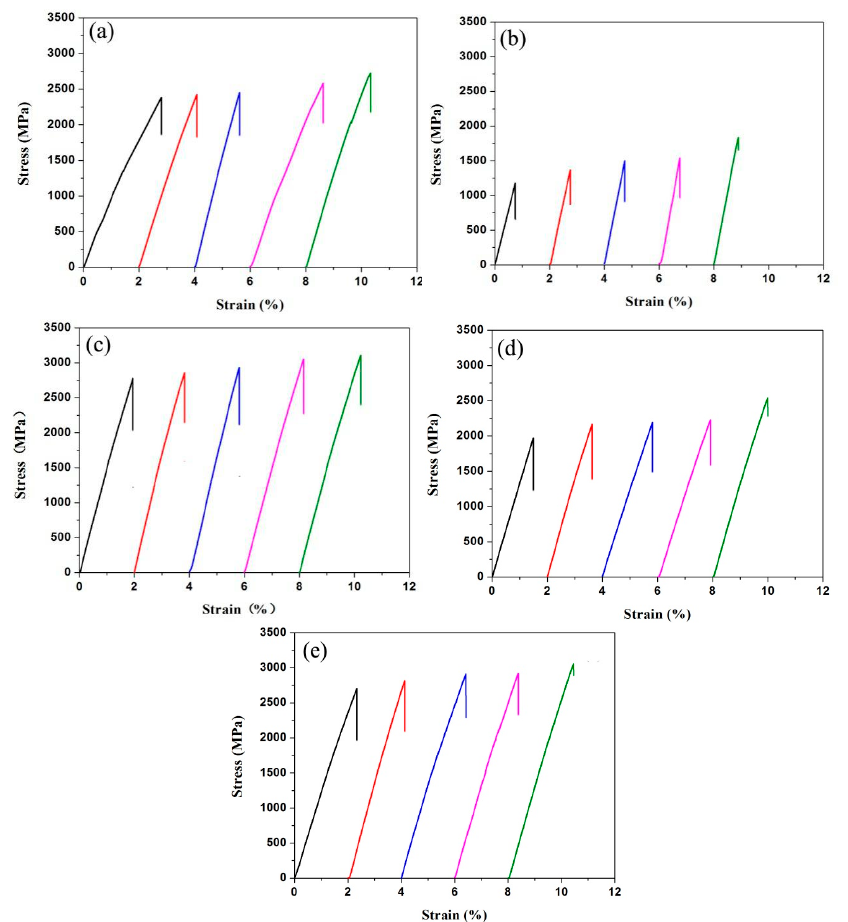
Figure 7. Tensile stress ‐ strain curves of Fe 76.5 − x Cu 1 Nb x Si 13.5 B 9 fibers: ( a ) x = 0, d = 25 μ m; ( b ) x = 1, d = 15 µ m; ( c ) x = 2, d = 15 µ m; ( d ) x = 3, d = 25 µ m; ( e ) x = 3.5, d = 15 µ m.